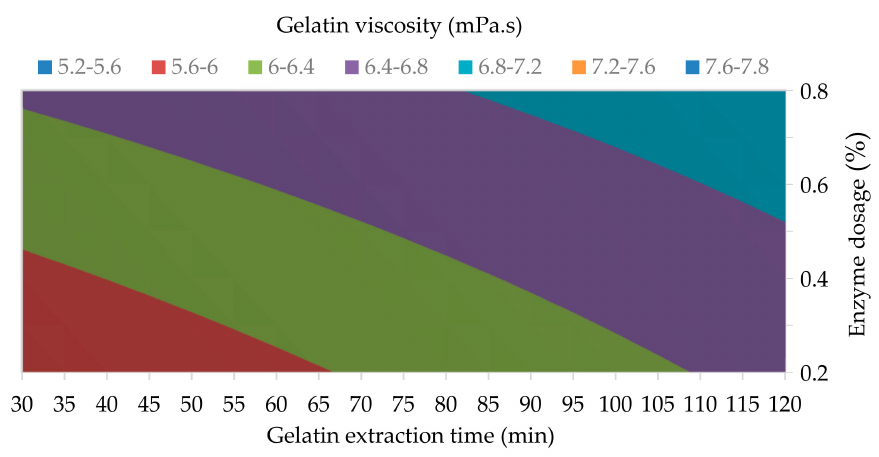
Figure 3. The influence of enzyme dosage and gelatin extraction time (at 48 h of enzyme processing time) on the gelatin viscosity.